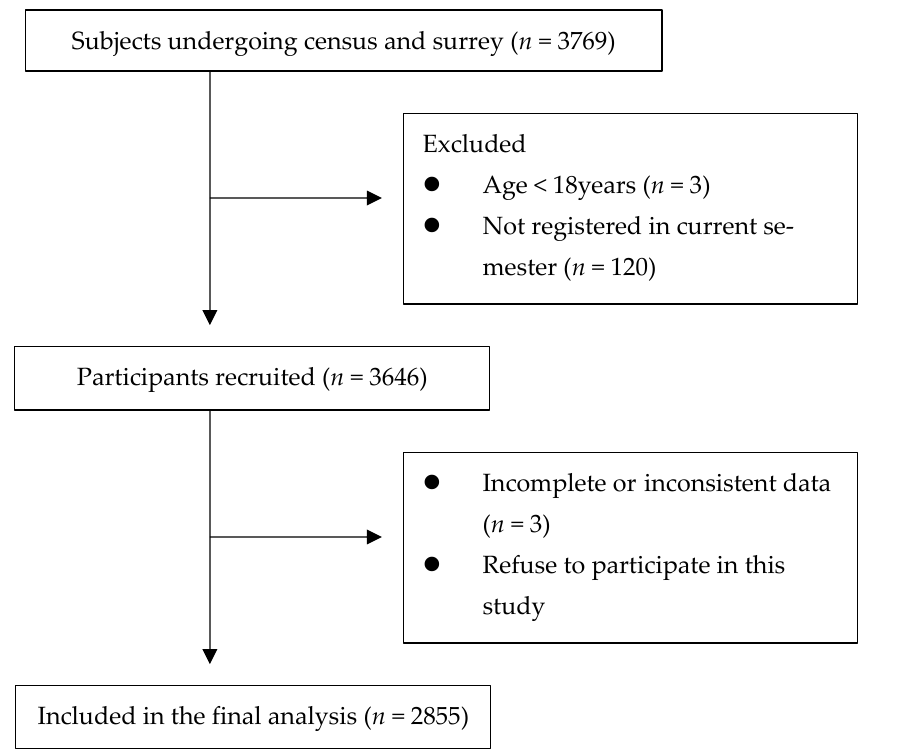
Figure 1. Flow chart of participant recruitment.